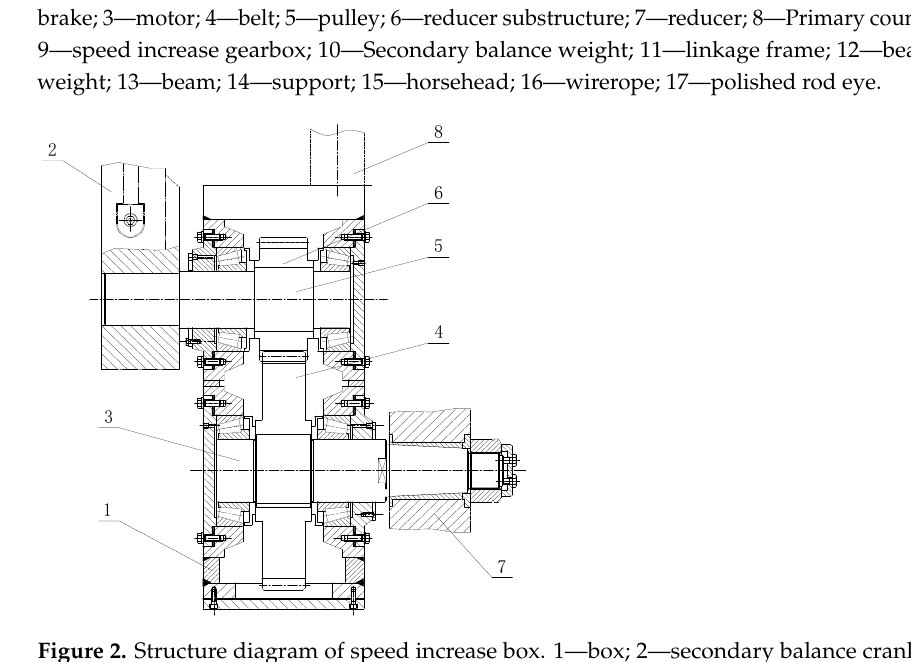
Figure 2. Structure diagram of speed increase box. 1—box; 2—secondary balance crank; 3—input shaft; 4—large gear; 5—output shaft; 6—small gear; 7—big crank; 8—connecting rod frame.